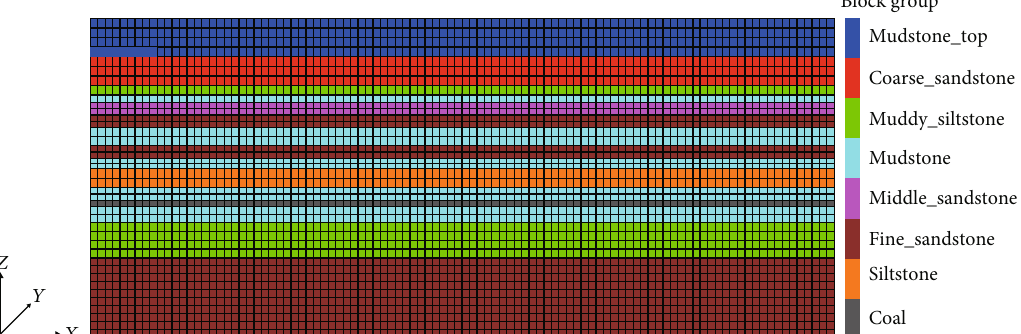
Figure 10: Numerical simulation model.